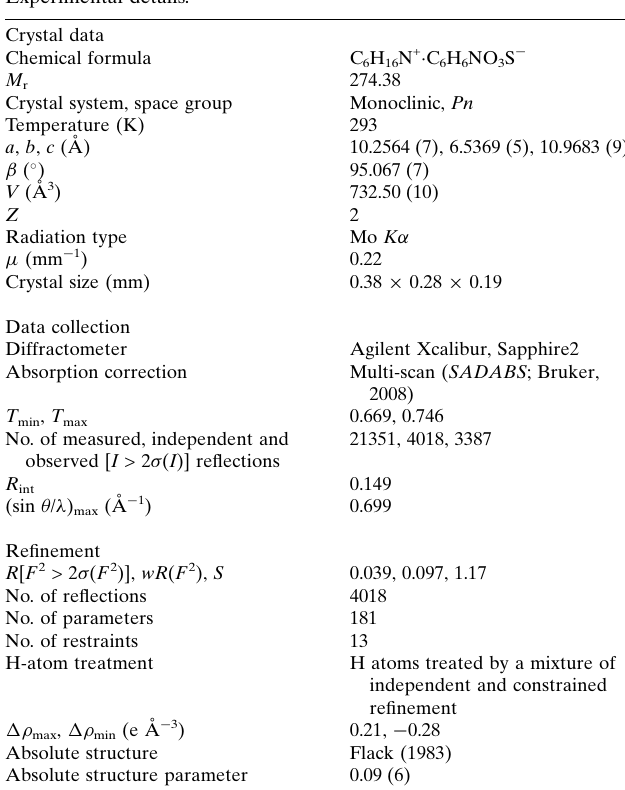
Table 2 Experimental